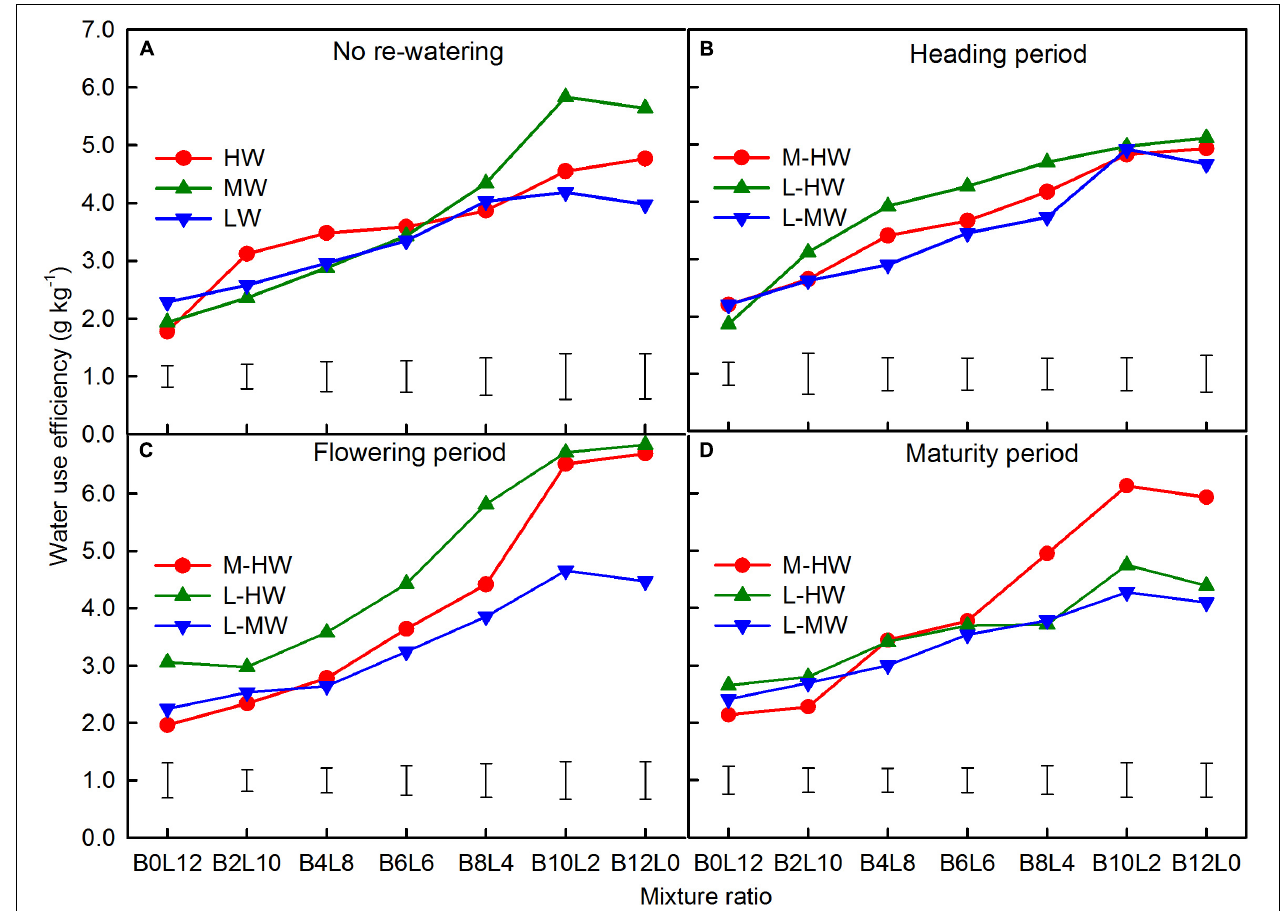
FIGURE 7 | (A–D) The water use efficiency (WUE) based on the total biomass production and water transpired by B. ischaemum (B) and L. davurica (L) under the soil watering treatments during different growth periods within the replacement series. B i L j ( i, j = 0, 2, 4, 6, 8, 10, 12; i + j = 12) in abscissa indicates the plant numbers of B. ischaemum to L. davurica in the mixtures; Vertical bars represent LSD 0.05 values. Refer to Figure 1 for the codes of the water treatments.